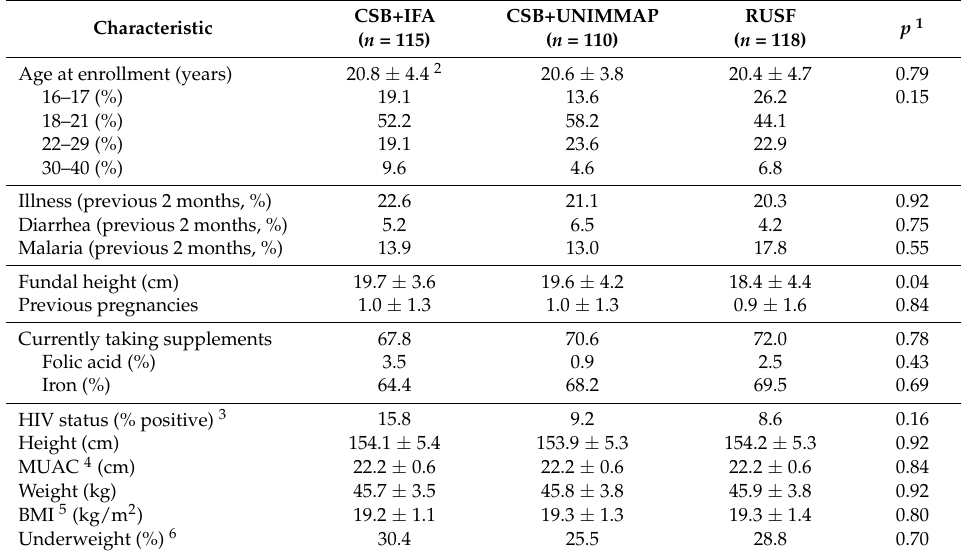
Table 3. Selected characteristics of the participants at enrollment, by treatment